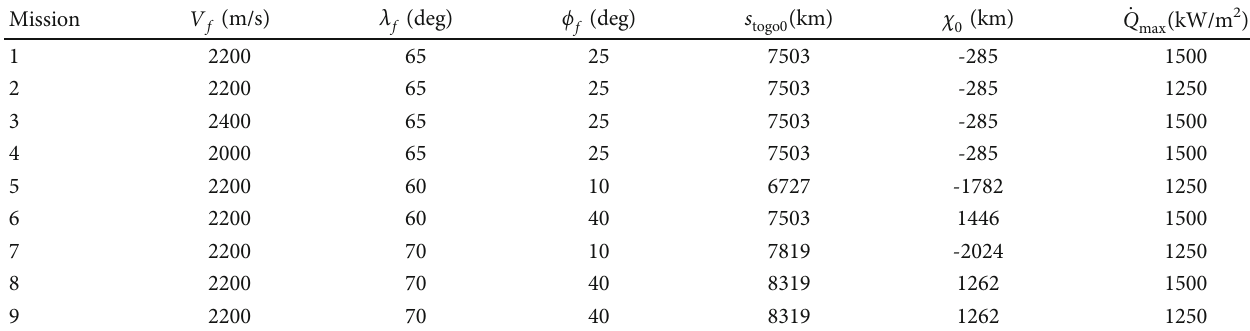
Table 1: Entry mission